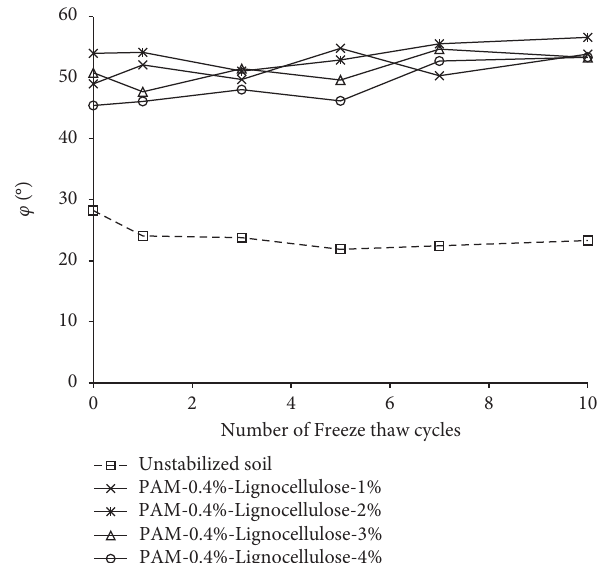
Figure 15: Changes of internal friction angle of stabilized PAM and lignocellulose samples with freeze-thaw